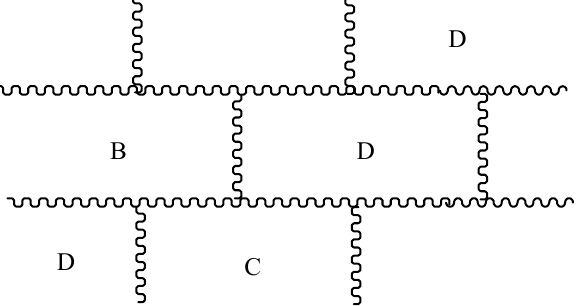
Table 3. Mechanical characterization of the rubber samples